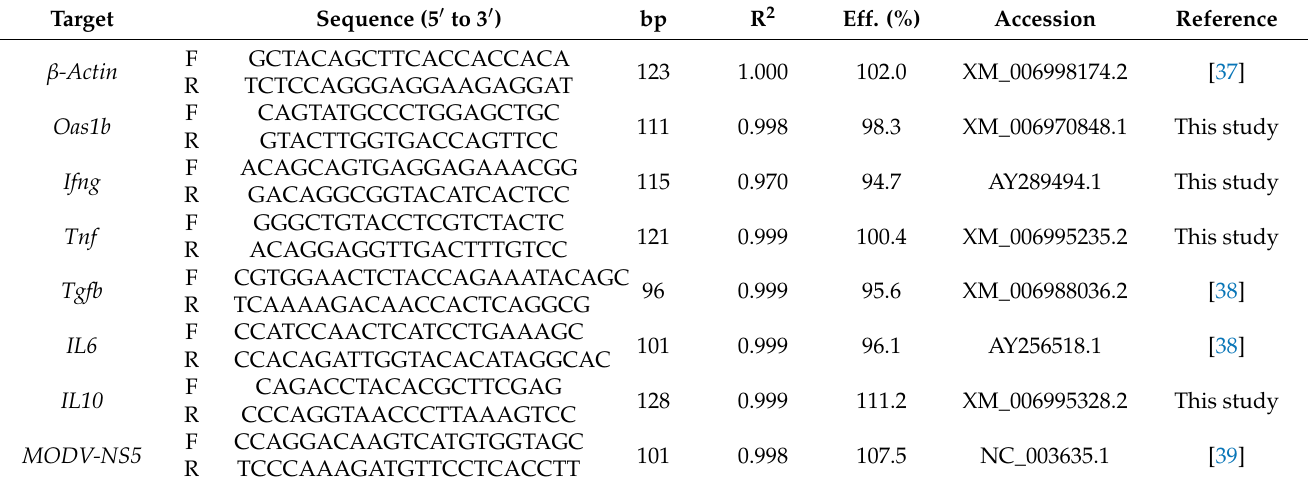
Table 1. Sequence data and amplification efficiency for Peromyscus maniculatus